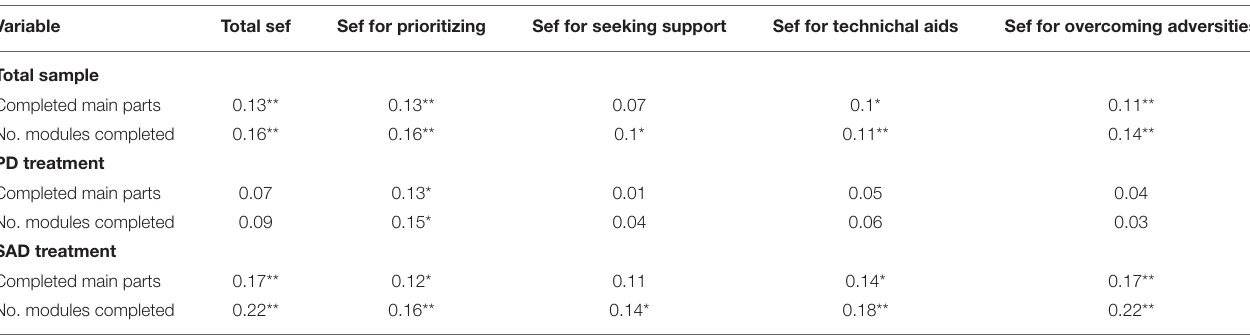
TABLE 5 | Pearson correlation matrix between self-efficacy and dropout.